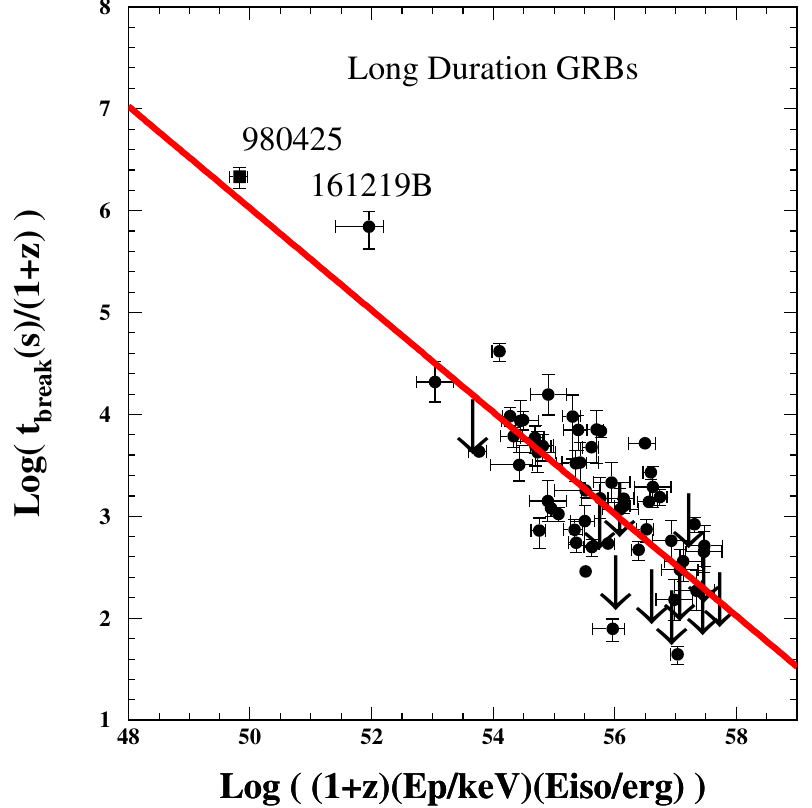
Figure 12. The break time t b / ( 1 + z ) of the X-ray AG of SN-GRBs measured with the Swift XRT [95,96], as a function of [( 1 + z ) E p E iso ] . The line is the CB model correlation of Equation (6), expected in SN-GRBs. SN-Less GRBs, to be discussed in Section 6.2, are not